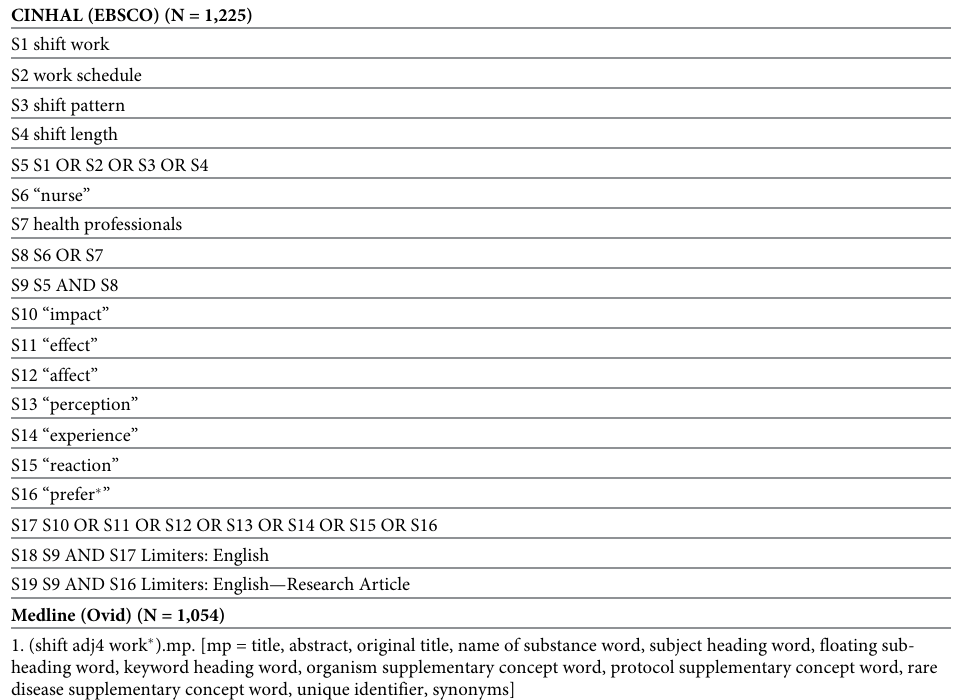
Table 1. Search strategy for scoping review on nurses’ experience and preferences around shift